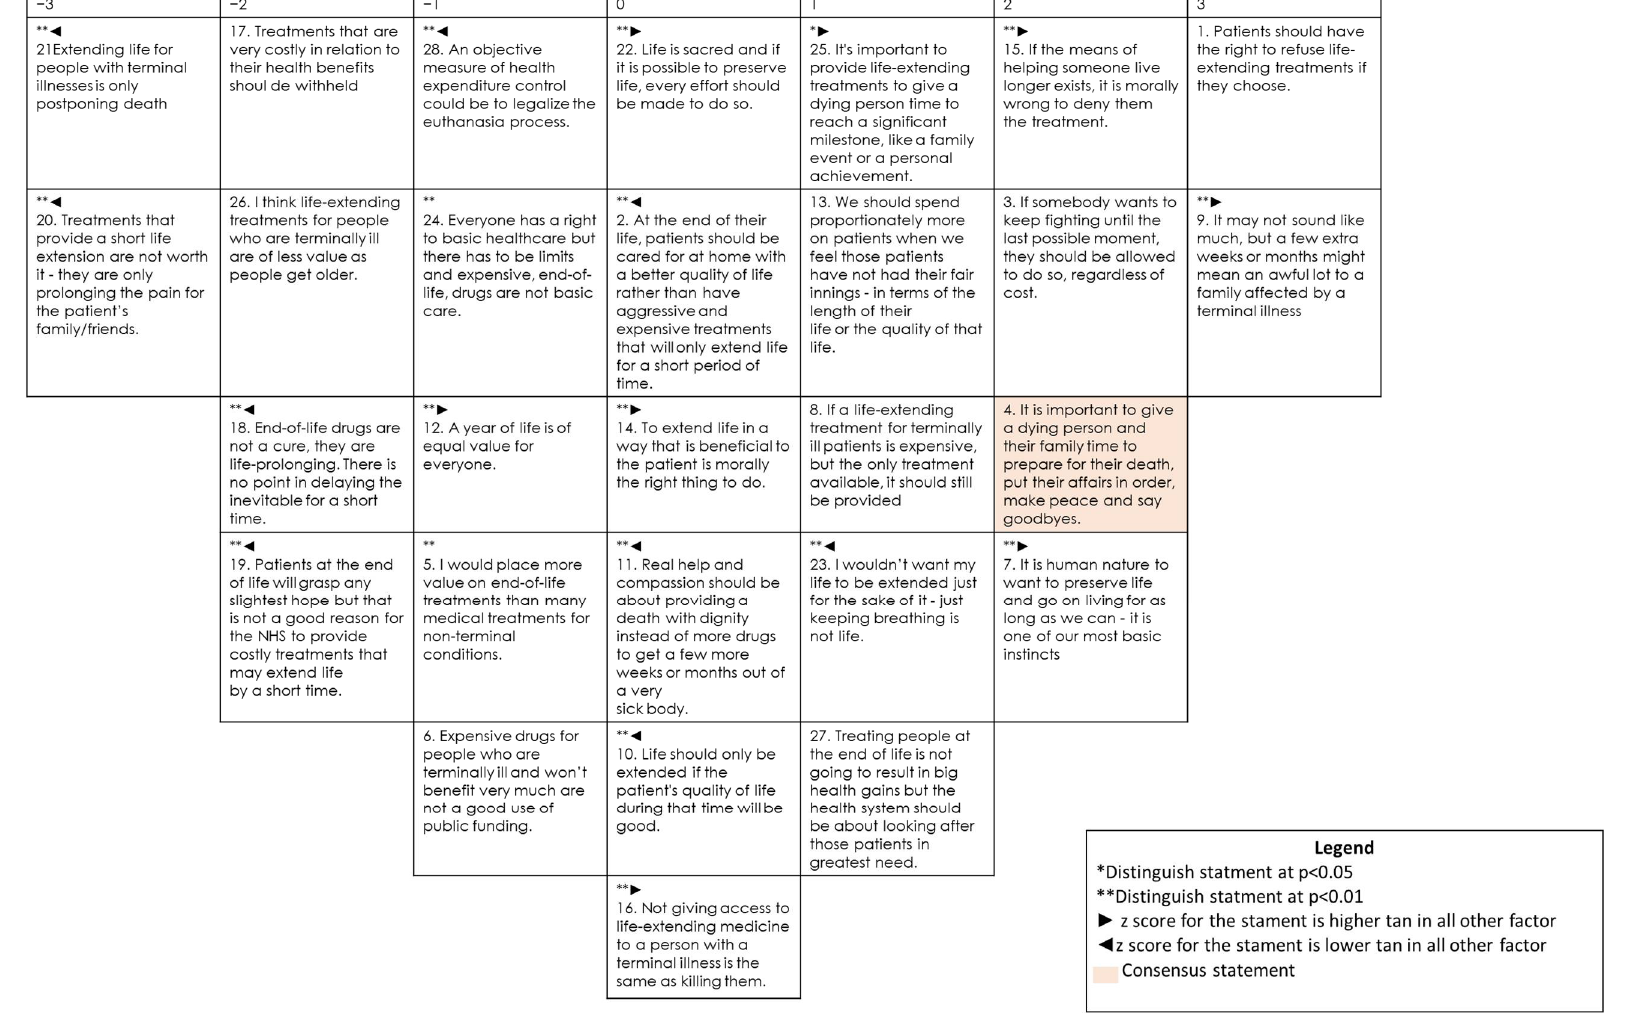
Figure 2. Composite Q sort for factor 2 .